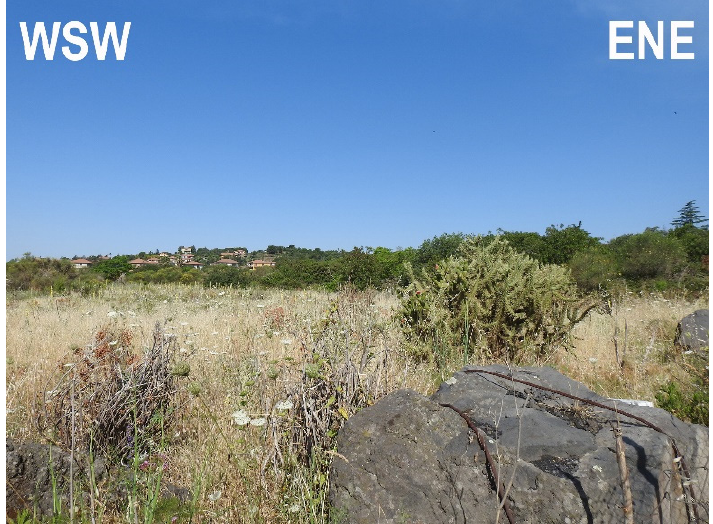
Figure 7. View of the burial site (seen by Teocrito Street, Figure 5B). The burial site is on the back of the southern uncultivated and abandoned field (in the foreground), in the middle of the Mediterranean Macchia (in the background).